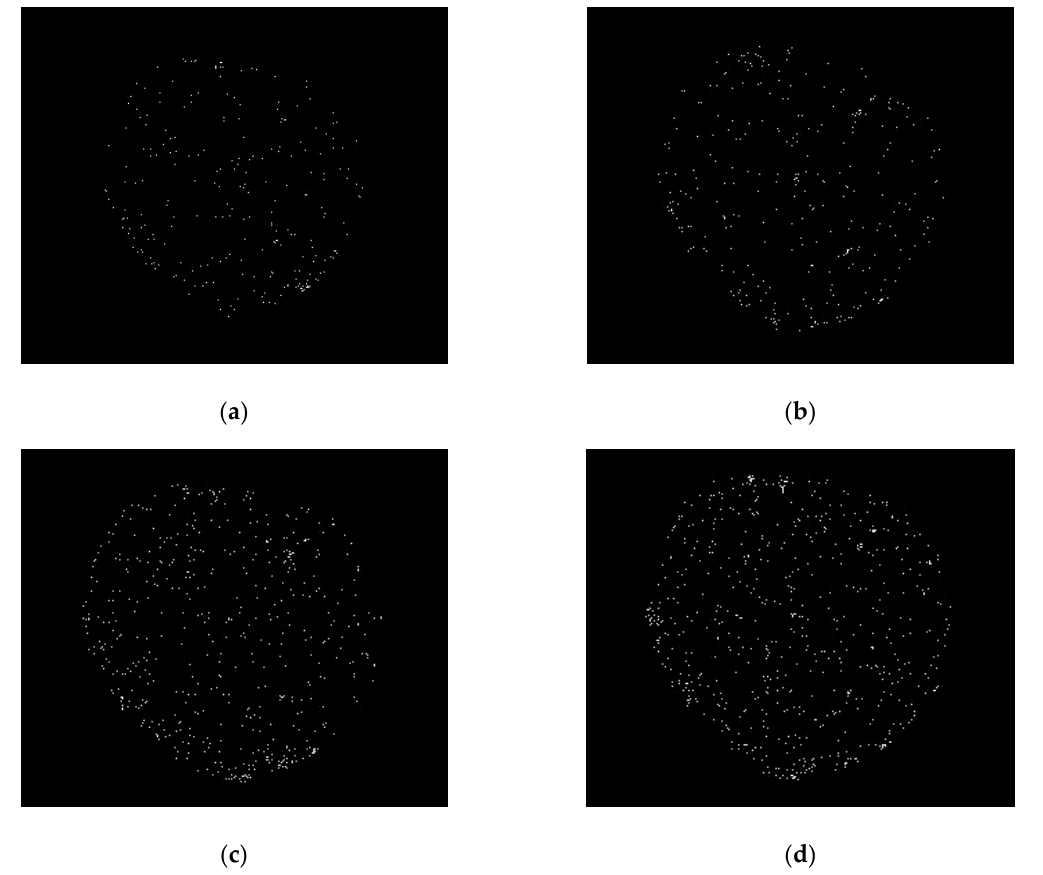
Figure 12. Background noise measured with the incident source removed under different ambient temperature conditions ( T A ). Long collection times, such as 120 s, were selected to avoid random error in the experiment: ( a ) T A = 300 K, N D = 0.610 c/(s·cm 2 ); ( b ) T A = 310 K, N D = 0.770 c/(s·cm 2 ); ( c ) T A = 320 K, N D = 1.405 c/(s·cm 2 ); ( d ) T A = 330 K, N D = 1.793 c/(s·cm 2 ).